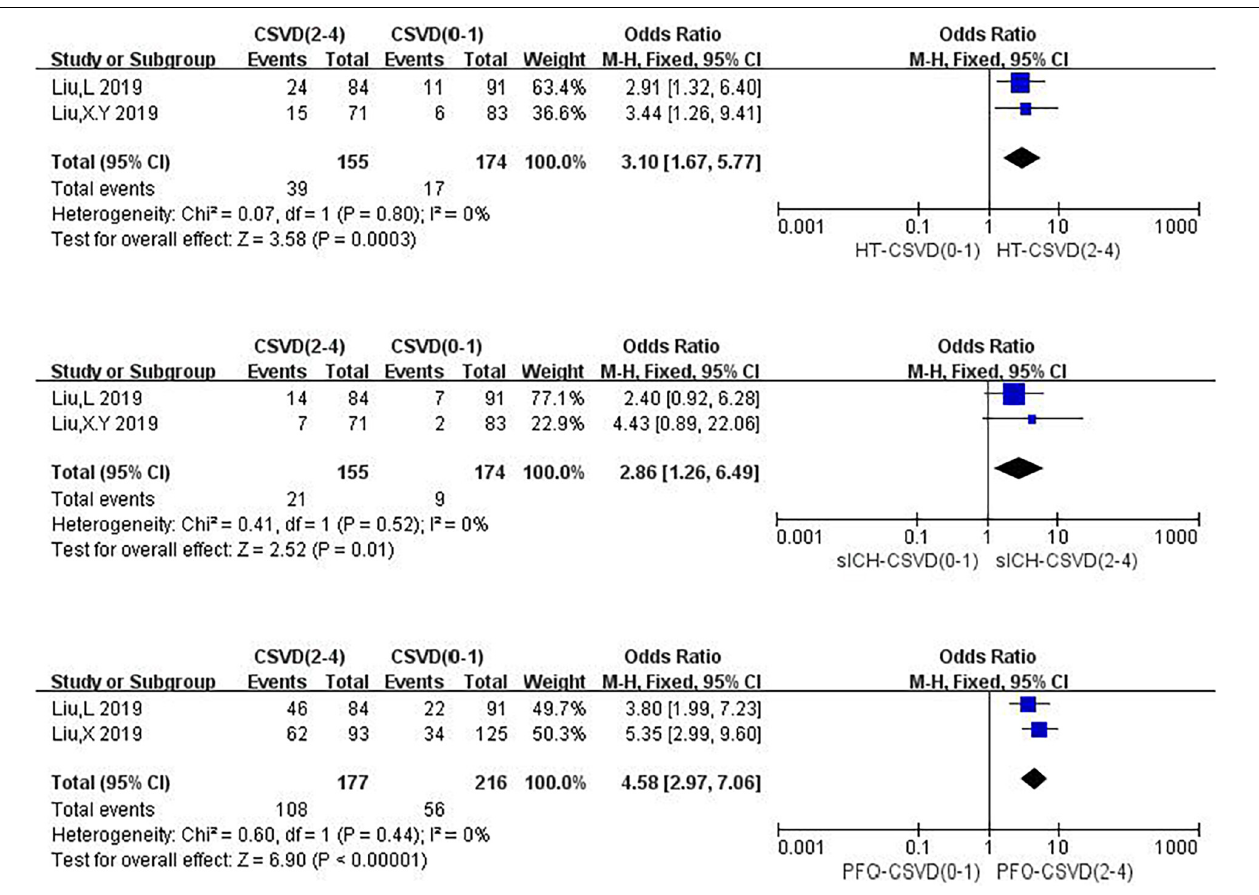
FIGURE 11 | Forest plot showing the impact of CSVD score on HT, sICH and 3-months